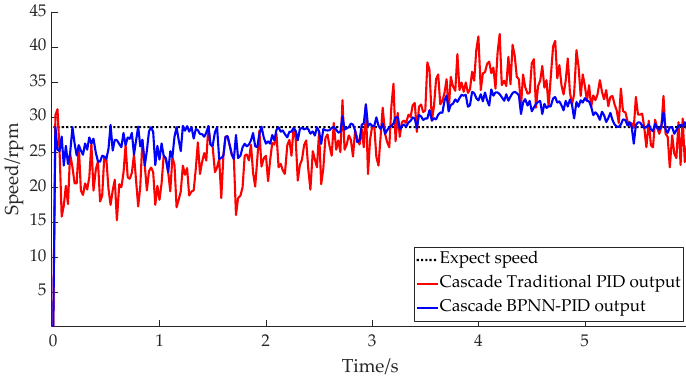
Figure 10. Responses of main motor rotating mechanisms.